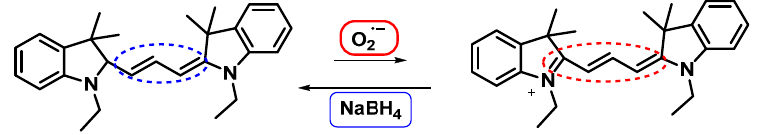
Figure 70. The oxidation–reduction reaction of hydrocyanines and cyanines.